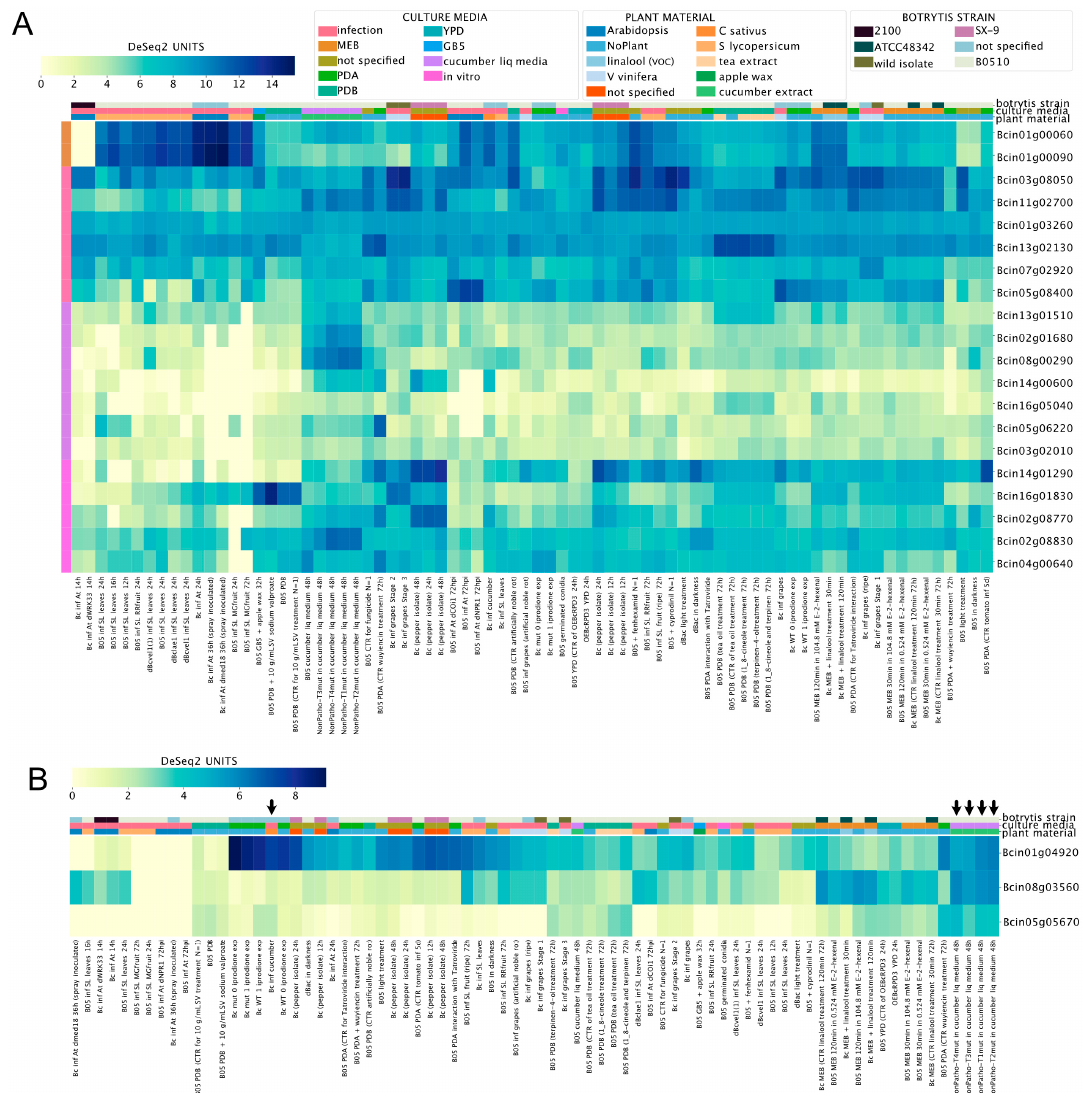
Figure 4. Polyketide synthetases ( A , PKS) and diterpene cyclases ( B ) expression levels across exper- imental conditions. Both heatmaps indicate transcript levels with their corresponding expression scale from yellow to dark blue (low or high expression, respectively). The legend at the top of the figure denotes culture conditions and B. cinerea strains. Experimental conditions and genes are depicted in columns and rows, respectively. Gene IDs are provided at the right of each heatmap. A detailed description of each experiment is provided at the bottom of each heatmap (SRA IDs were not included). Columns denoted with arrows (in B ) are discussed in the main text.